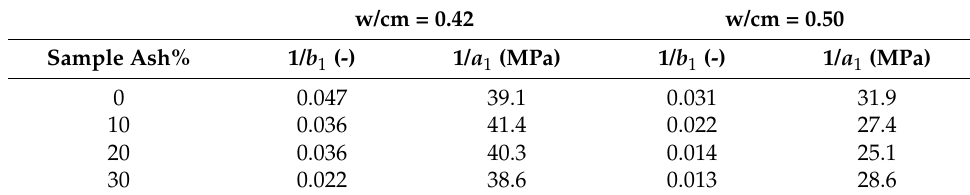
Table 6. Parameters fitting Equation (1) to describe the specimen compressive